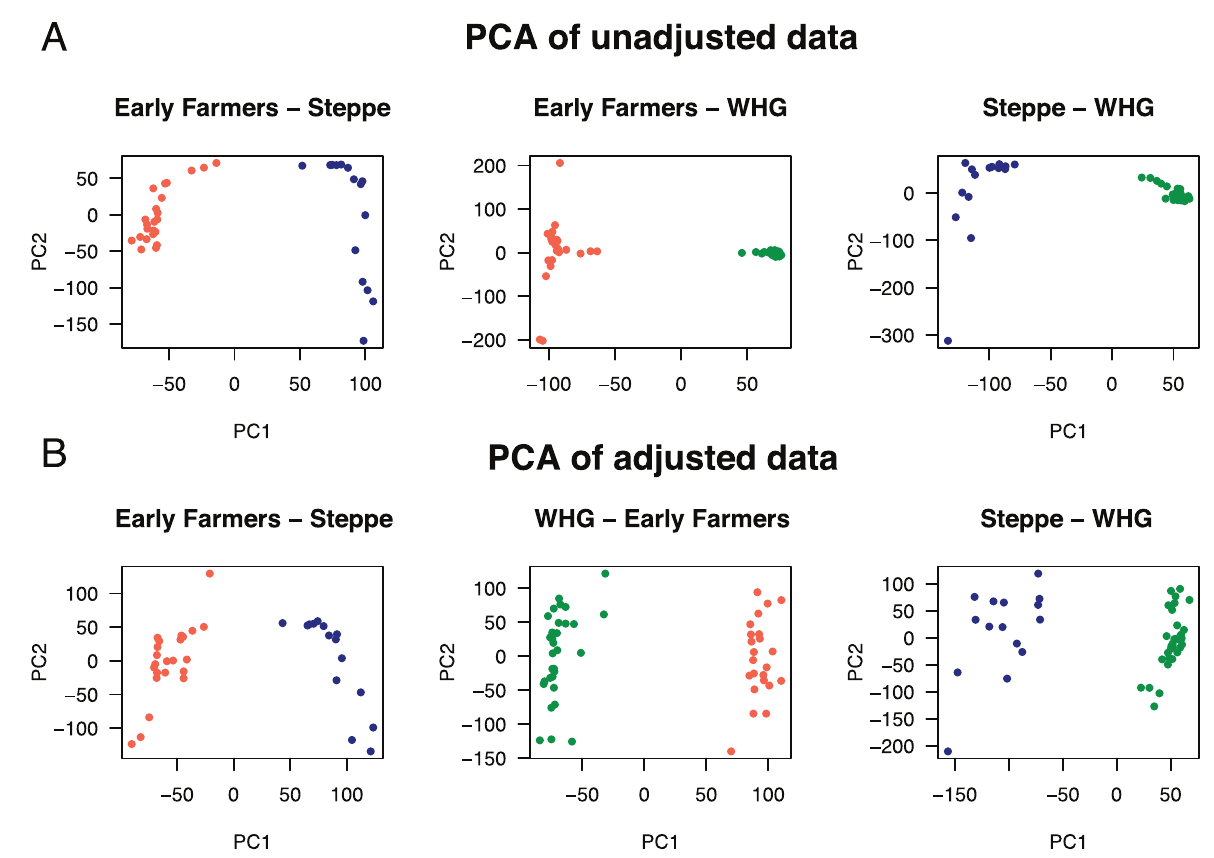
Fig 5. Correction for coverage in PC plots for pairs of ancient population samples. ( A ) PCA of unadjusted genotypes. ( B ) PCA of non-binary genotypic data adjusted for coverage. Population samples: Early Farmers (salmon color, n 1 = 23), Steppe pastoralists (blue color, n 2 = 15), (Western Hunter Gatherers, green color, n 3 =